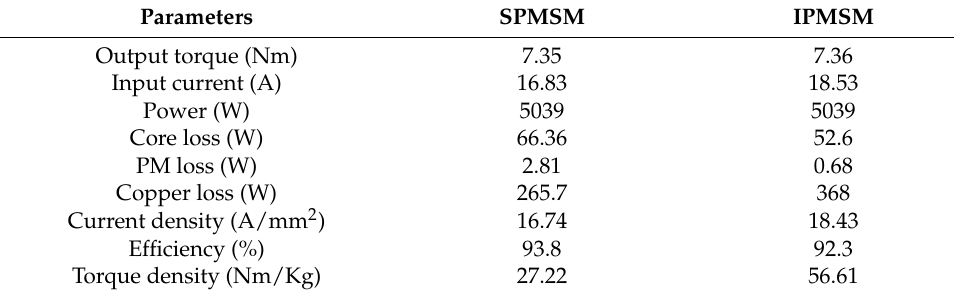
Table 3. Analysis